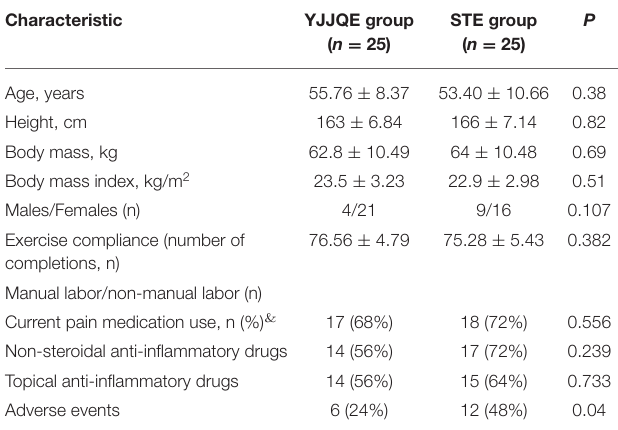
TABLE 3 | Demographic and clinical characteristics of the YJJQE and STE groups*.